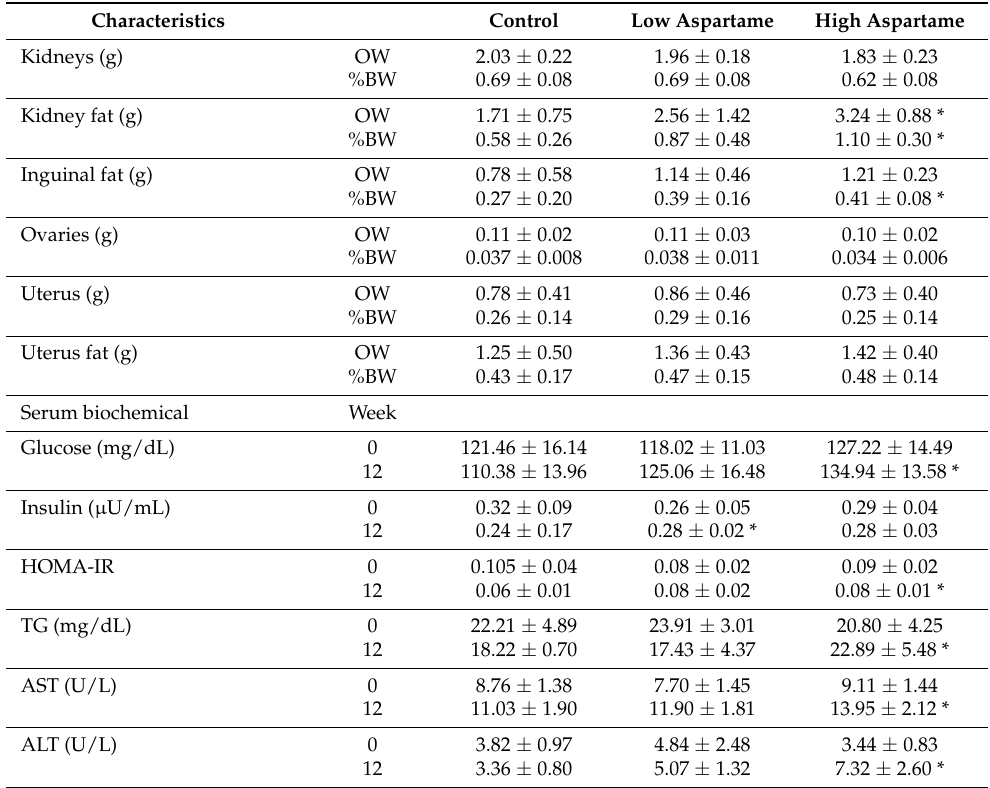
Figure 2. Effect of aspartame treatment on the protein levels of antioxidant enzymes and oxidative stress in rats and cells. Aspartame-treated groups contain lower antioxidant enzymes and higher oxidative stress in ovary and KGN cells. ( A ) The protein levels of catalase (60 kDa), the most abun- dant and effective enzyme in cytosol (n = 5). ( B ) The protein levels of superoxide dismutase-2 (25 kDa), a mitochondrial antioxidant enzyme (n = 5). The western blot data are normalized with GAPDH so that value of the control is regarded as 1.0. ( C ) 8-OHdG levels, oxidative stress caused DNA damage (n = 5). ( D ) MDA, oxidative stress caused lipid peroxidation (n = 5). ( E ) After KGN cells were treated with 5–20 mM aspartame for 48 h, cells were collected and stained with DCFDA followed by flow cytometry analysis. Quantitative results of ROS are shown in the plot (n = 3). NAC